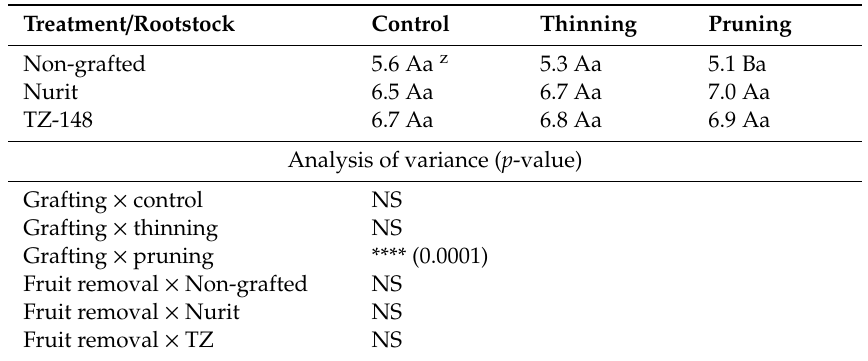
Table 2. E ff ects of rootstock, pruning and fruit-thinning on average marketable fruit weight ( > 5 kg) at harvest (means of two year data).